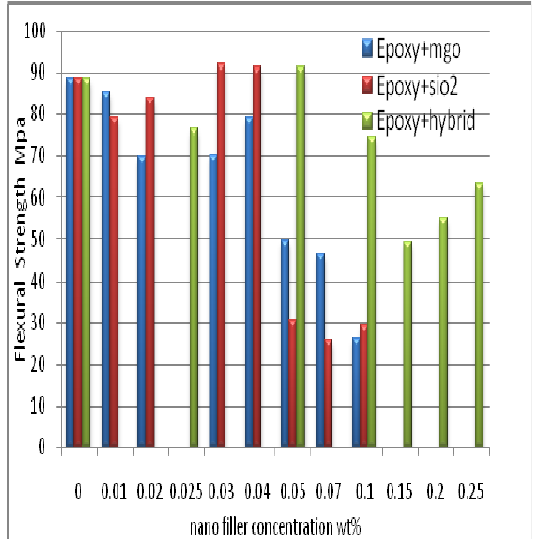
Fig. 2: The behavior of flexural strength with nano filler